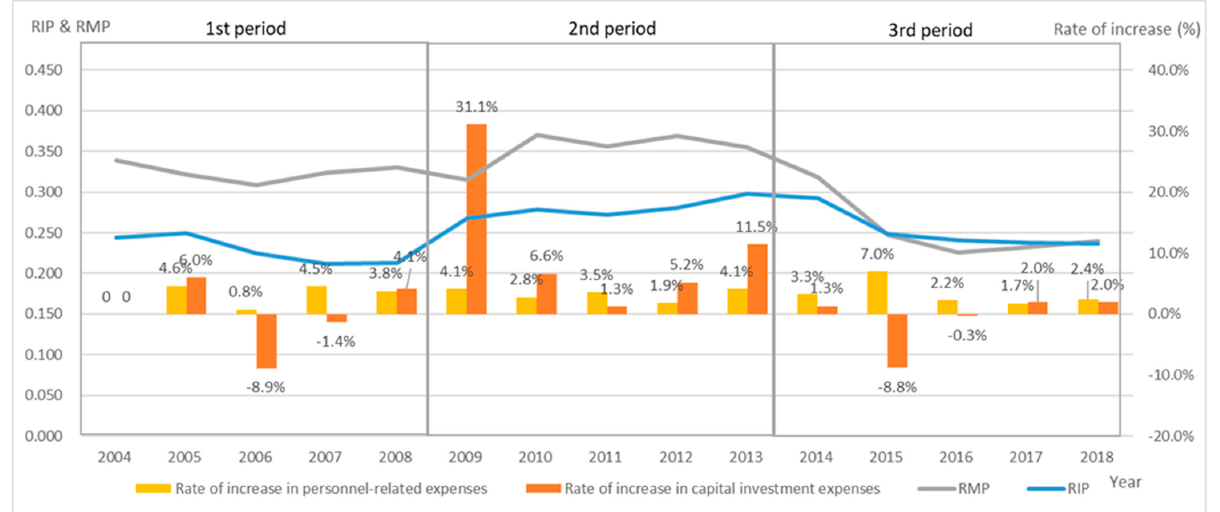
Figure 4. Relationship between RIP and the rate of capital investment expenses of all NHO hospitals.